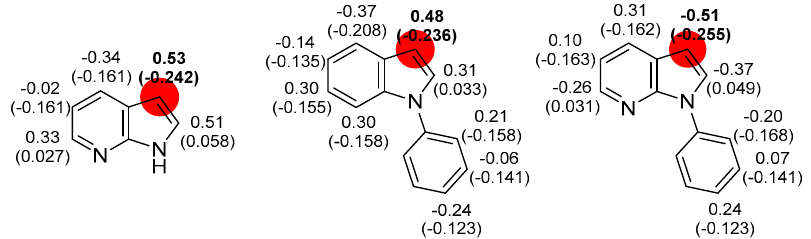
Figure 9. Calculated C charges (in brackets) and HOMO coefficients obtained by using the HuLiS